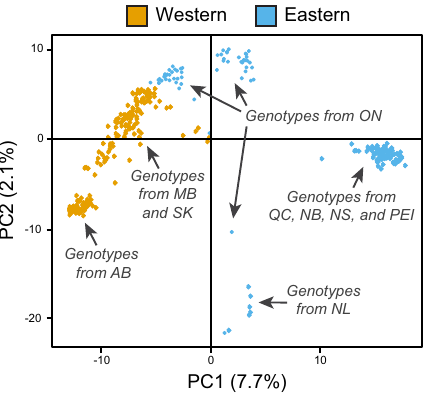
Figure 1. Principal component analysis (PCA) showing 324 genotypes of S. famelica and S. eriocephala , plotted as western and eastern groups, separated along the first two principal component (PC) axes (explaining 7.7% and 2.1% of the total variation, respectively). AB, Alberta; SK, Saskatchewan; MB, Manitoba; ON, Ontario; QC, Quebec; NB, New Brunswick; NS, Nova Scotia; PEI, Prince Edward Island; NL, Newfoundland and